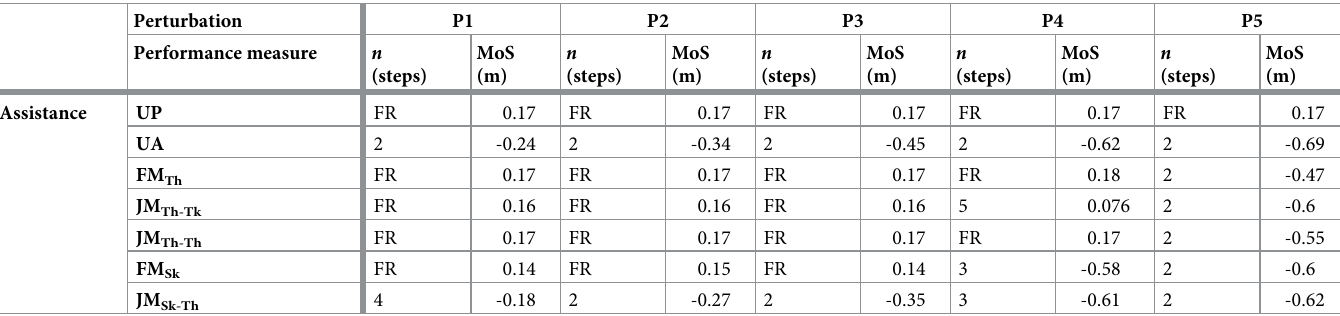
Table 2. Performance of best case response to perturbations